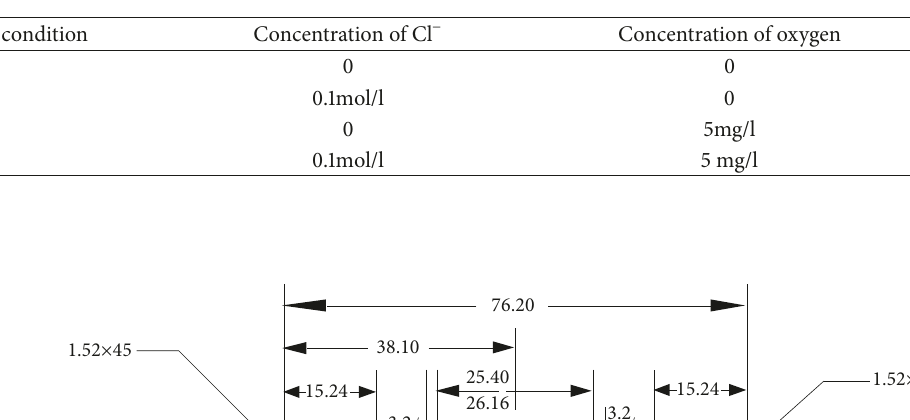
Table 2: The experimental condition of the specimens.